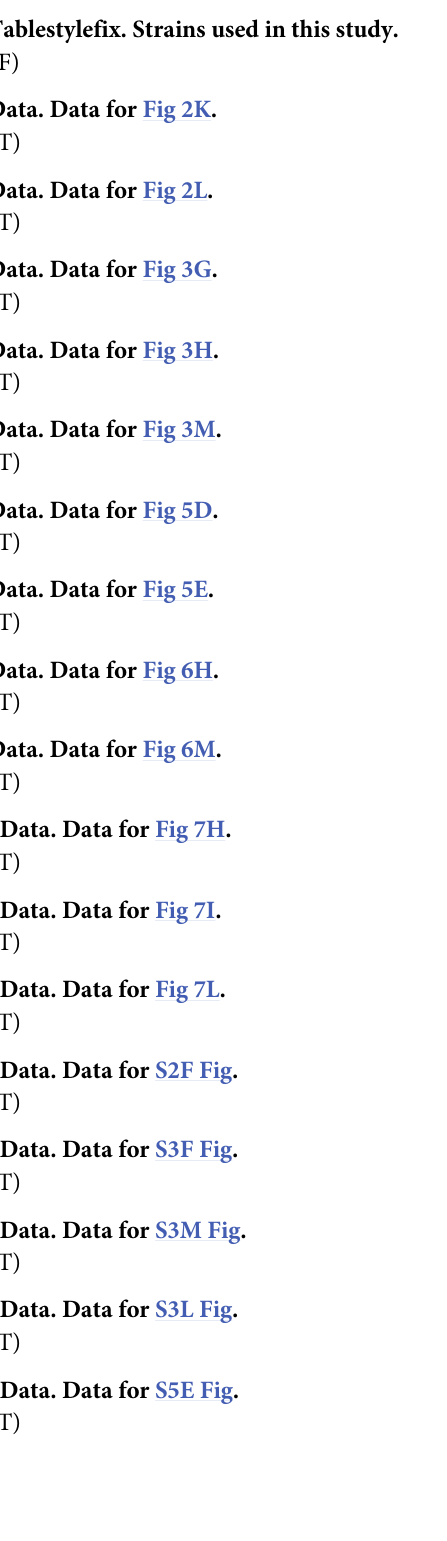
S4 Data. Data for Fig 3H. S5 Data. Data for Fig 3M.